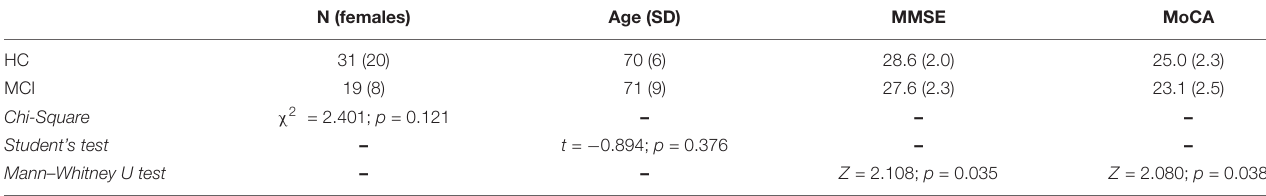
TABLE 1 | Complete subjects and cognitive scores